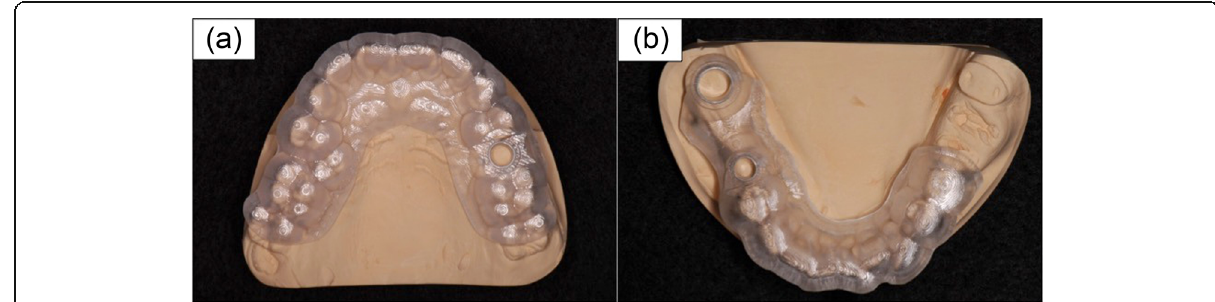
Fig. 3 Example of missing teeth-derived factors. a Tooth type: premolar, types of edentulism: intermediate defect, and the distance from the remaining tooth to the placement position: 1 tooth. b Tooth type: premolar and molar, types of edentulism: free-end defects, and the distance from the remaining tooth to the placement position: 1 tooth and 3 teeth